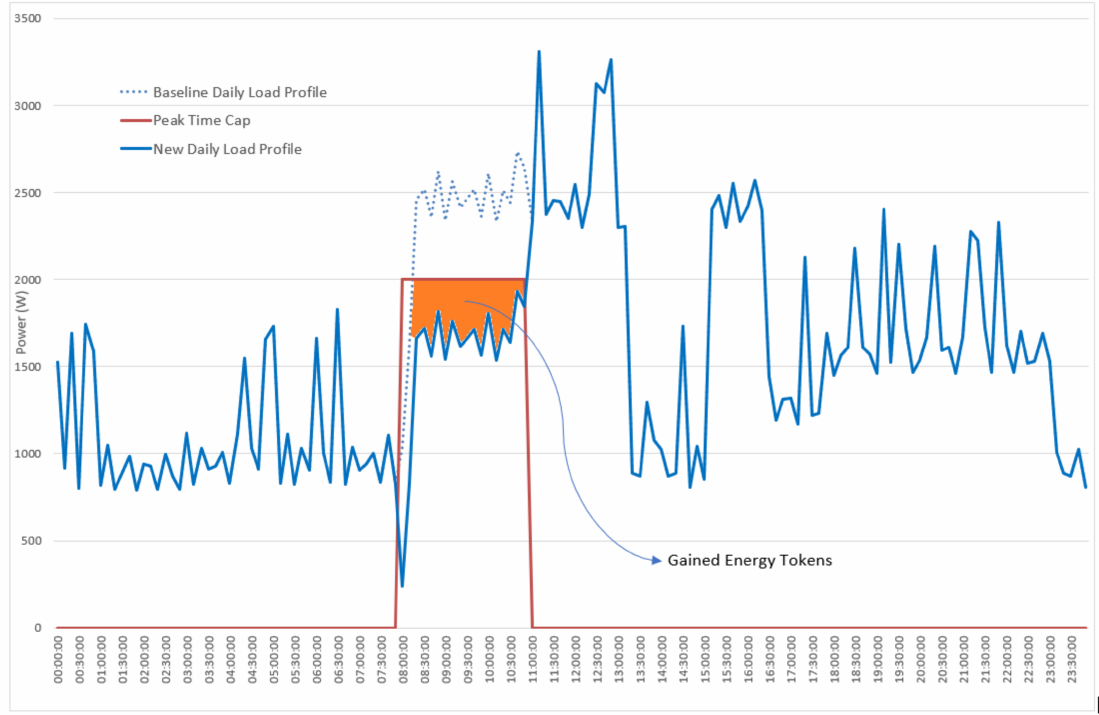
Figure 16. Energy Cap and Trade Peak Load Shaving